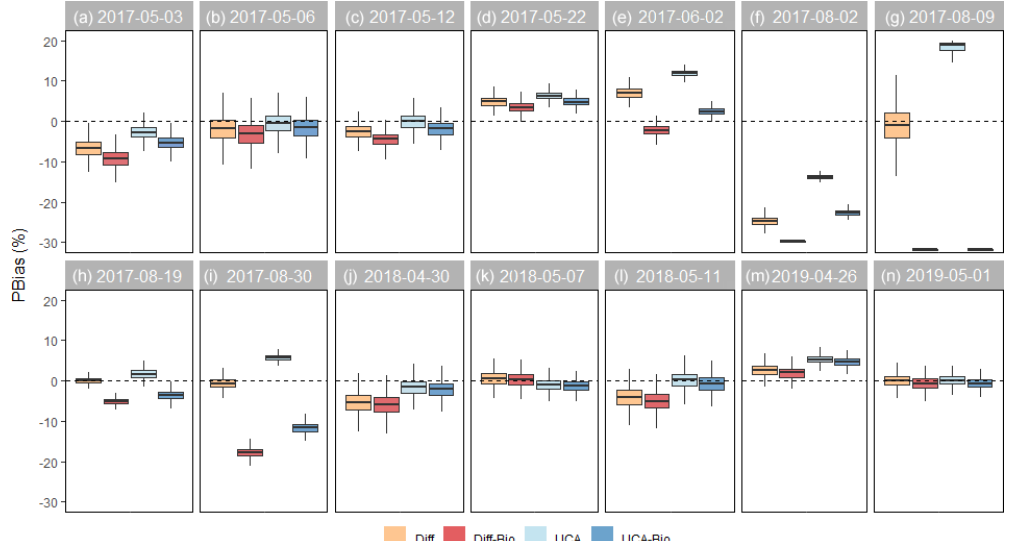
Figure 5. Relative bias (PBias) by model and sampling campaign. For each model, boxplots show the median and 25th and 75th percentiles, and whiskers extend to the 10th and 90th percentiles of the 10000 runs. Values close to 0 indicate that the model successfully simulates the magnitude of stream DOC concentrations. The horizontal line at PBias = 0 is shown as a